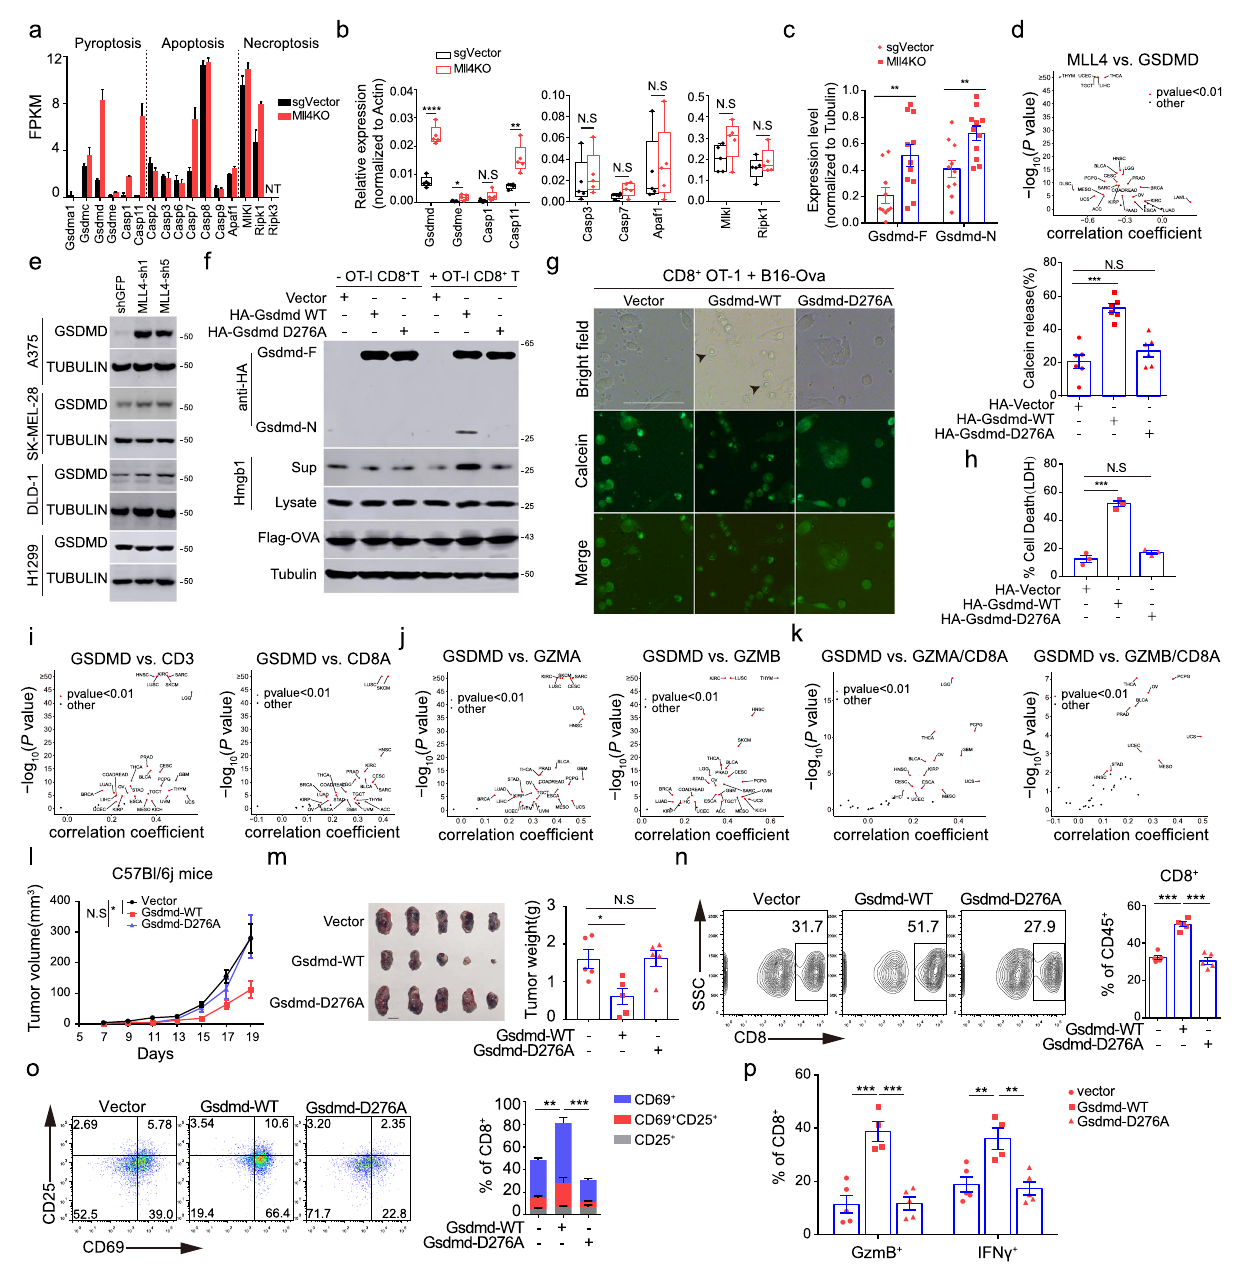
Fig. 4 | Mll4 ablation derepresses GSDMD to mediate pyroptosis in B16 mela- nomacells.a RNA-seqFPKMvalueforindicatedgenesincontroland Mll4 − / − tumor cells (mean±SEM, n =2). b Box plot showing expression of indicated genes in control and Mll4 − / − B16 bulk tumors ( n =5). Center line, mean; box bounds, upper and lower quartile; whisker, maximal and minimal value ( n =5). c Levels of full- length or the truncated N-terminal GSDMD protein in control and Mll4 − / − B16 bulk tumors are shown as mean±SEM (sgVector, n =10; Mll4KO, n =11). d , i – k Volcano plotsshowingTCGApan-cancerRNA-seqanalysesoftheSpearman ’ scorrelationfor the indicatedcomparisons. e Immunoblotting analyses of GSDMD level in human cancercelllines with or without MLL4 knockdown. f , h OT-1 T cells wereincubated with B16-Ova cells expressing vehicle, WT or mutant Gsdmd at an E/T ratio of 10:1 for 24h. Levels of indicated protein in co-culture supernatant and tumor-cell extractswereanalyzedbyimmunoblotting( f ).Tumor-celldeathwasdeterminedby LDH release and shown as mean±SEM from technical triplicates in one of